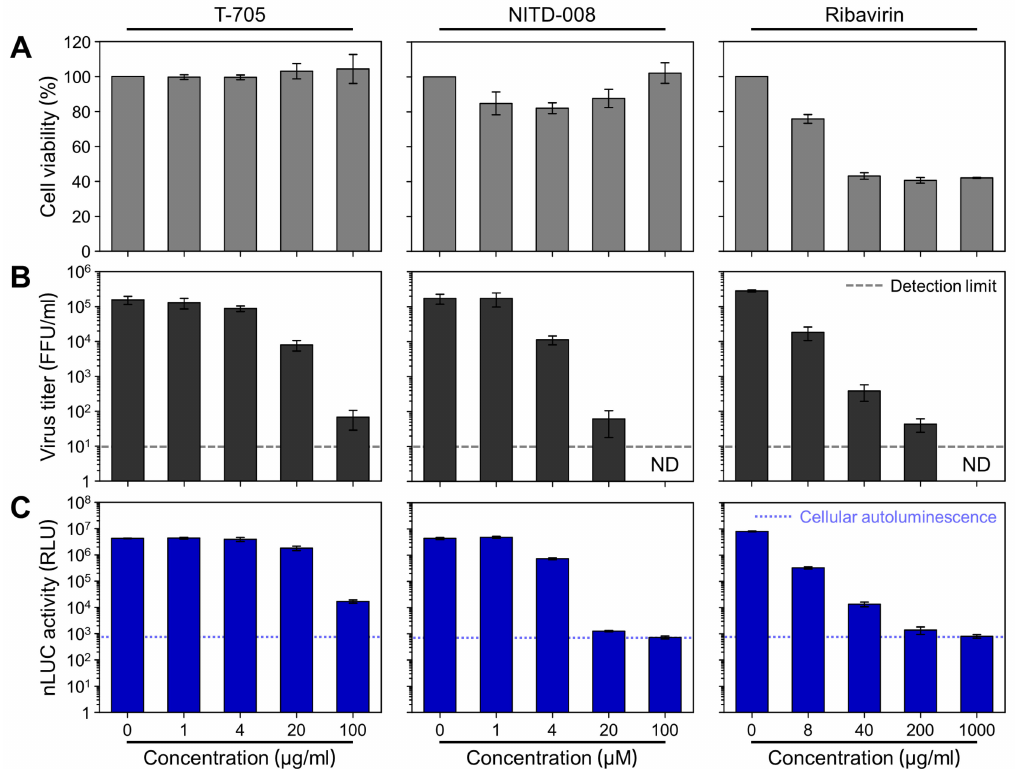
Figure 7. Application of rZIKV-nLUC for testing antiviral compounds. ( A ) Cell toxicity. BHK-21 cells were treated with T-705 (0, 1, 4, 20, and 100 µ g / mL), NITD-008 (0, 1, 4, 20, and 100 µ M), or ribavirin (0, 8, 40, 200, and 1000 µ g / mL) for 48 h. At the end of the incubation, cell viability was measured using the CellTiter-Blue Cell Viability Assay. ( B , C ) Antiviral activity. BHK-21 cells were mock-infected or infected with rZIKV-nLUC at a MOI of 0.1 and treated with T-705, NITD-008, or ribavirin at one of the indicated concentrations for 48 h. Antiviral activity was analyzed with regard to both the level of extracellular virus production in culture supernatants using our α -NS3 antibody-based immunofocus assay ( B ) and the level of intracellular nLUC expression in cell lysates using the Nano-Glo Luciferase Assay ( C ). The data represent mean values, and the error bars show standard deviations. ND, Not